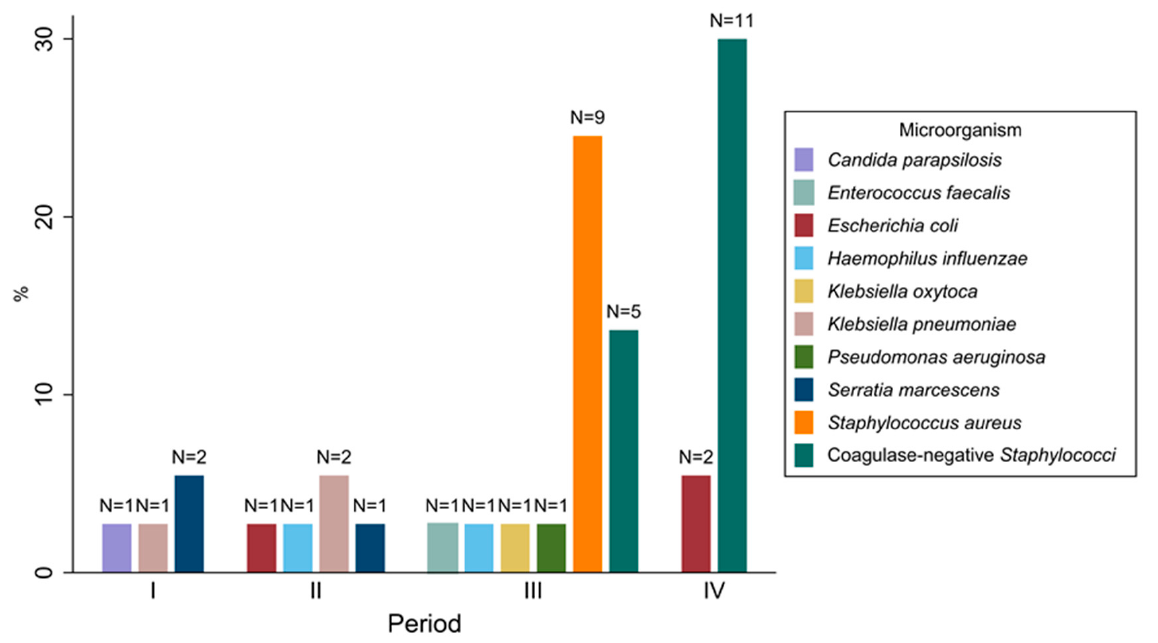
Figure 3. Frequency of isolation of microorganisms (N = 40) responsible for the healthcare-associated infections occurring in patients admitted to the neonatal intensive care unit of Umberto I teaching hospital of Rome between March 2018 and February 2022 by study period.